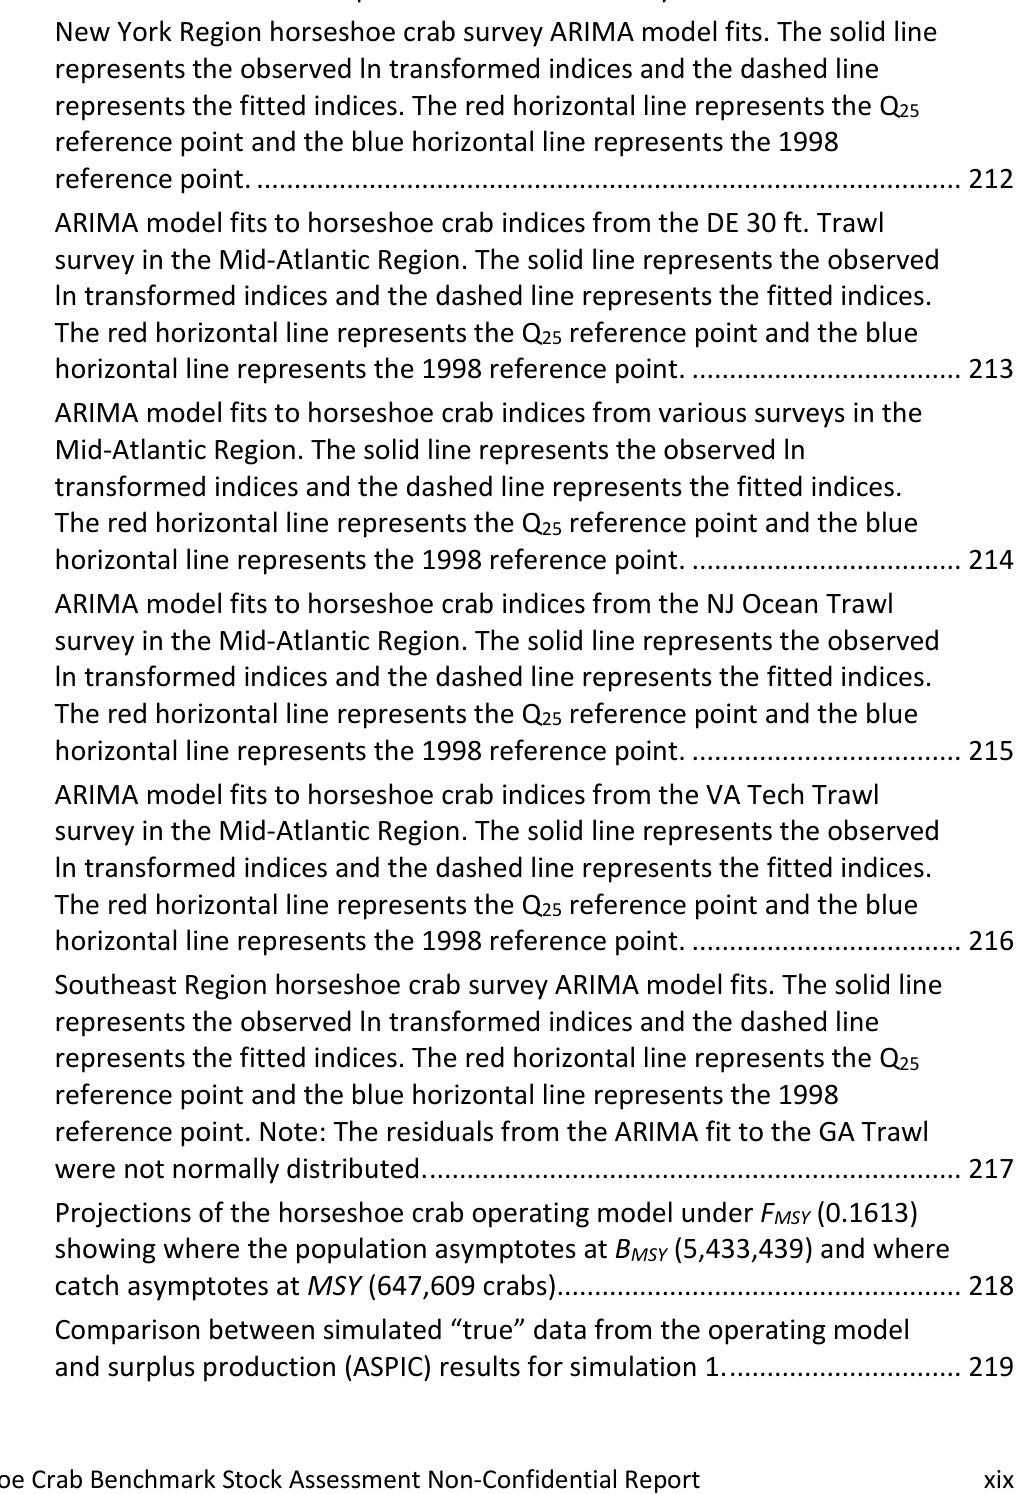
Figure 83. Northeast Region horseshoe crab survey ARIMA model fits. The solid line represents the observed ln transformed indices and the dashed line represents the fitted indices. The red horizontal line represents the Q 25 reference point and the blue horizontal line represents the 1998 reference point. Note: The residuals from the ARIMA model fit to the MA DMF Trawl – North of Cape Cod were not normally distributed. .................. 211 Figure 84. New York Region horseshoe crab survey ARIMA model fits. The solid line represents the observed ln transformed indices and the dashed line represents the fitted indices. The red horizontal line represents the Q 25 reference point and the blue horizontal line represents the 1998 reference point. .............................................................................................. 212 Figure 85. ARIMA model fits to horseshoe crab indices from the DE 30 ft. Trawl survey in the Mid-Atlantic Region. The solid line represents the observed ln transformed indices and the dashed line represents the fitted indices. The red horizontal line represents the Q 25 reference point and the blue horizontal line represents the 1998 reference point. .................................... 213 Figure 86. ARIMA model fits to horseshoe crab indices from various surveys in the Mid-Atlantic Region. The solid line represents the observed ln transformed indices and the dashed line represents the fitted indices. The red horizontal line represents the Q 25 reference point and the blue horizontal line represents the 1998 reference point. .................................... 214 Figure 87. ARIMA model fits to horseshoe crab indices from the NJ Ocean Trawl survey in the Mid-Atlantic Region. The solid line represents the observed ln transformed indices and the dashed line represents the fitted indices. The red horizontal line represents the Q 25 reference point and the blue horizontal line represents the 1998 reference point. .................................... 215 Figure 88. ARIMA model fits to horseshoe crab indices from the VA Tech Trawl survey in the Mid-Atlantic Region. The solid line represents the observed ln transformed indices and the dashed line represents the fitted indices. The red horizontal line represents the Q 25 reference point and the blue horizontal line represents the 1998 reference point. .................................... 216 Figure 89. Southeast Region horseshoe crab survey ARIMA model fits. The solid line represents the observed ln transformed indices and the dashed line represents the fitted indices. The red horizontal line represents the Q 25 reference point and the blue horizontal line represents the 1998 reference point. Note: The residuals from the ARIMA fit to the GA Trawl were not normally distributed. ....................................................................... 217 Figure 90. Projections of the horseshoe crab operating model under F MSY (0.1613) showing where the population asymptotes at B MSY (5,433,439) and where catch asymptotes at MSY (647,609 crabs)...................................................... 218 Figure 91. Comparison between simulated “true” data from the operating model and surplus production (ASPIC) results for simulation 1. ...............................